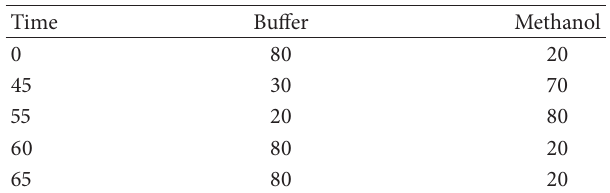
Table 4: Gradient